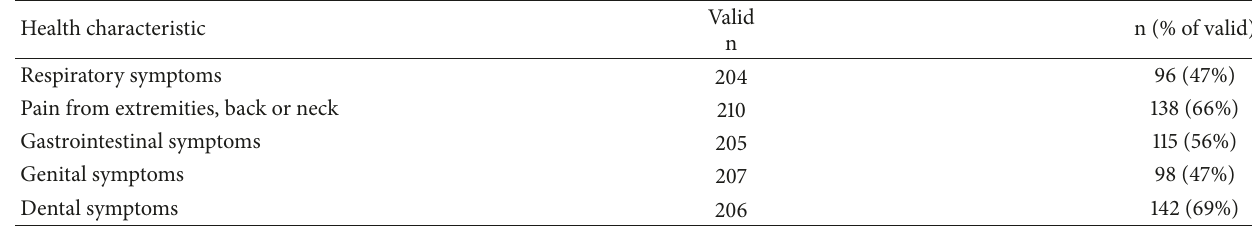
Table 2: Self-reported physical symptoms, N=218.